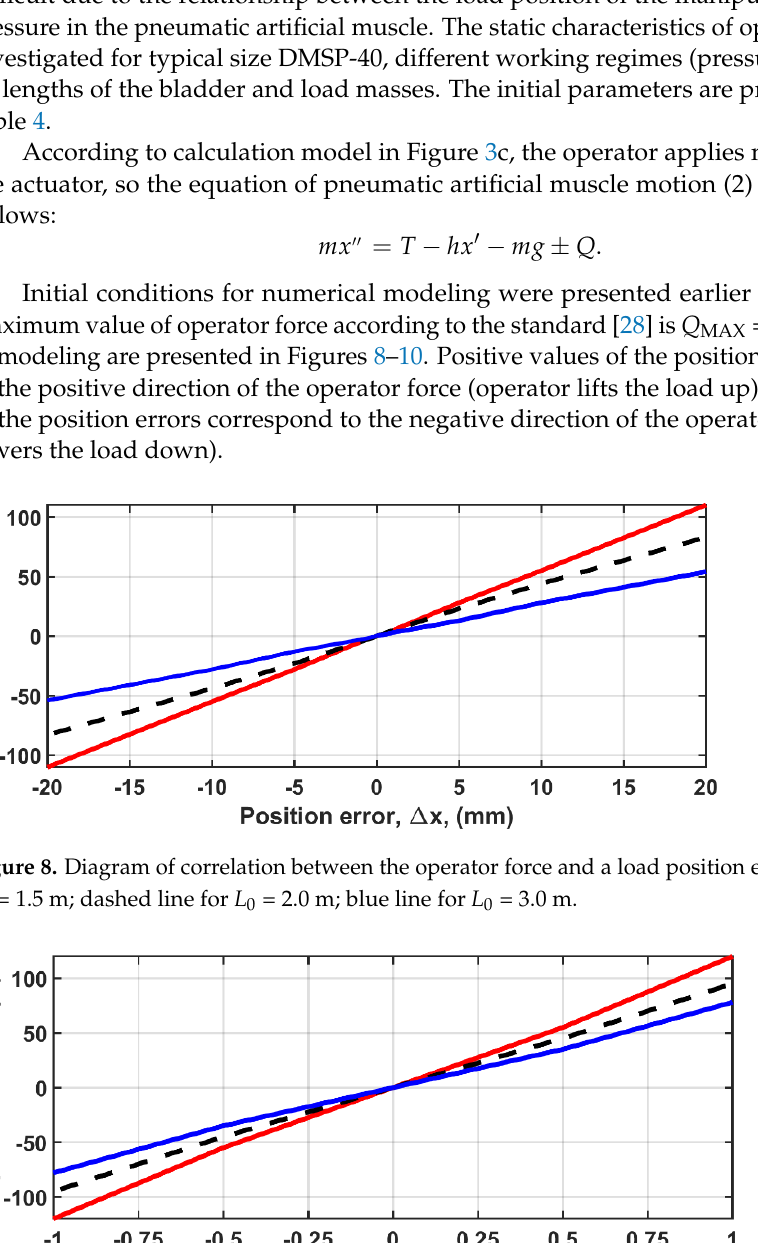
Figure 10. Diagram of correlation between the operator force and relative position error: solid line for m = 200 kg, dashed line for m = 150 kg, dotted line for m = 100 kg. Similar results can be obtained for other typical sizes of FESTO fluidic muscle and parameters (lengths, working pressures and load masses). It can be concluded that the operator can correct the position error in a wide range with an operator manual force of up to 50 N. 4. Experimental Validation Experiments were carried out to investigate the static and dynamic characteristics of the pneumatic artificial muscle and validate results obtained by the mathematical model (1) – (4) discussed above. Figure 11 shows the image of the experimental setup. The main part of the experimental setup is the pneumatic artificial muscle FESTO DMSP-10-400NPM-CM. The pneumatic artificial muscle has an initial diameter of 10 mm